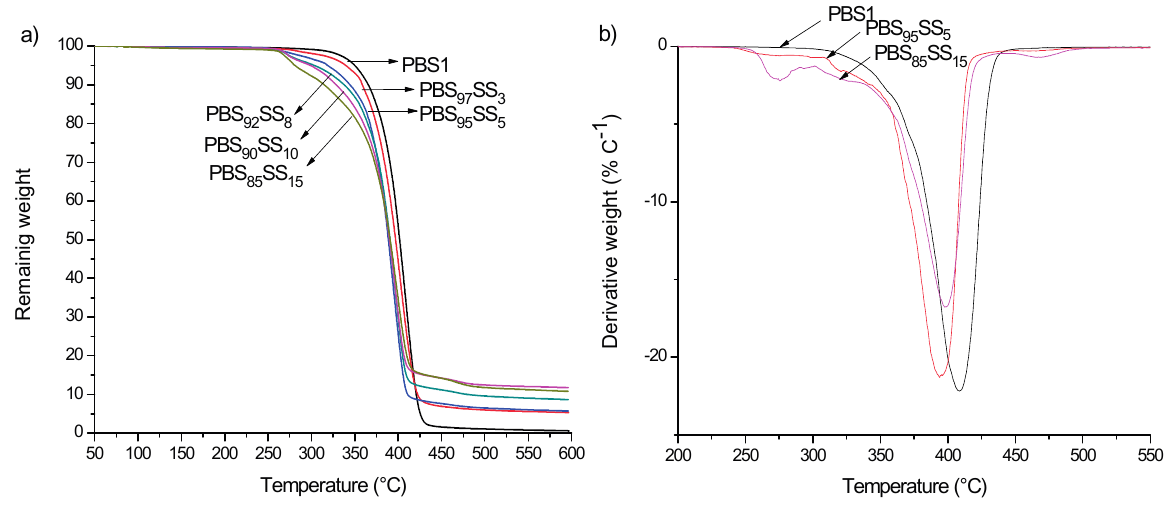
SS ; ( b ) Derivative curves of PBS1 and a selection of x y